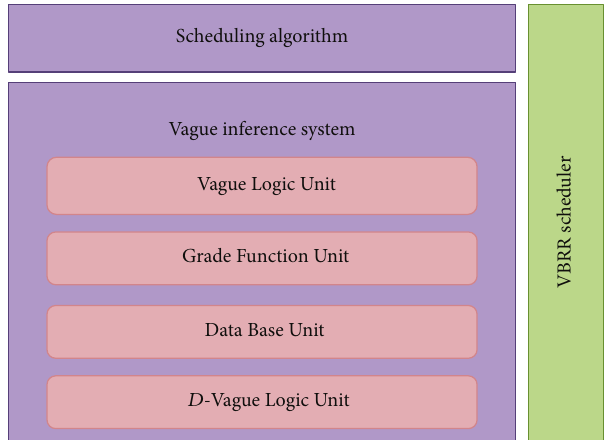
Figure 4: 2-layered framework for VBRR scheduler.